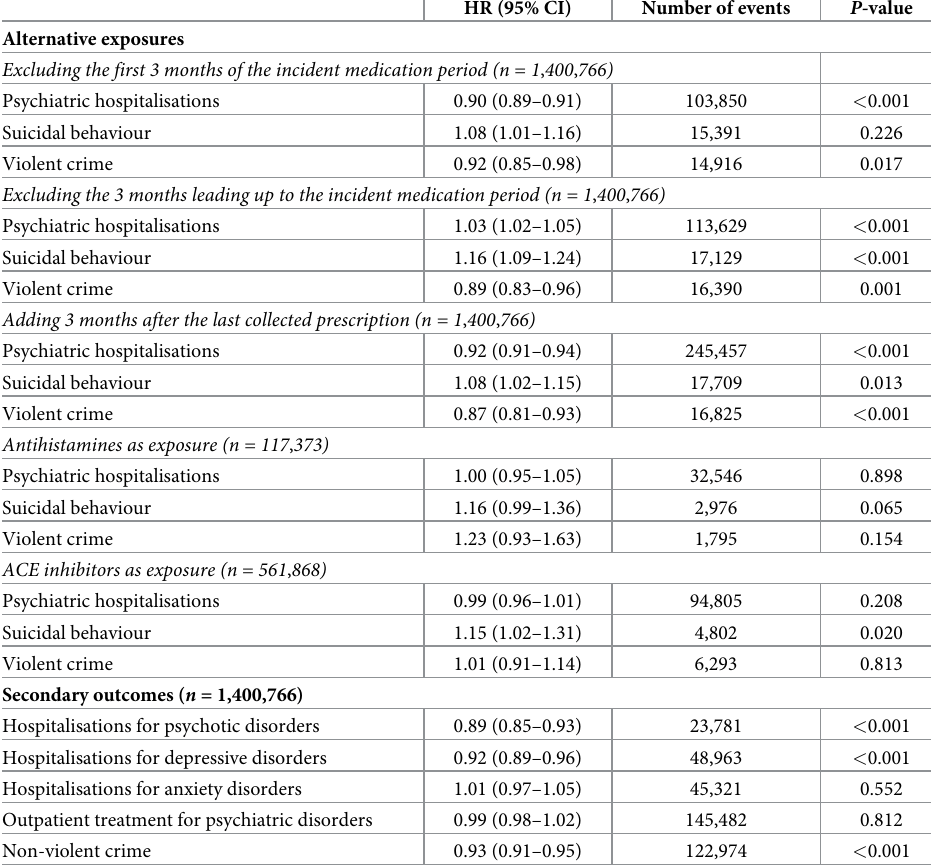
Table 2. Sensitivity analyses; age-adjusted within-individual associations between β -blockers and psychiatric and behavioural outcomes using alternative exposures and